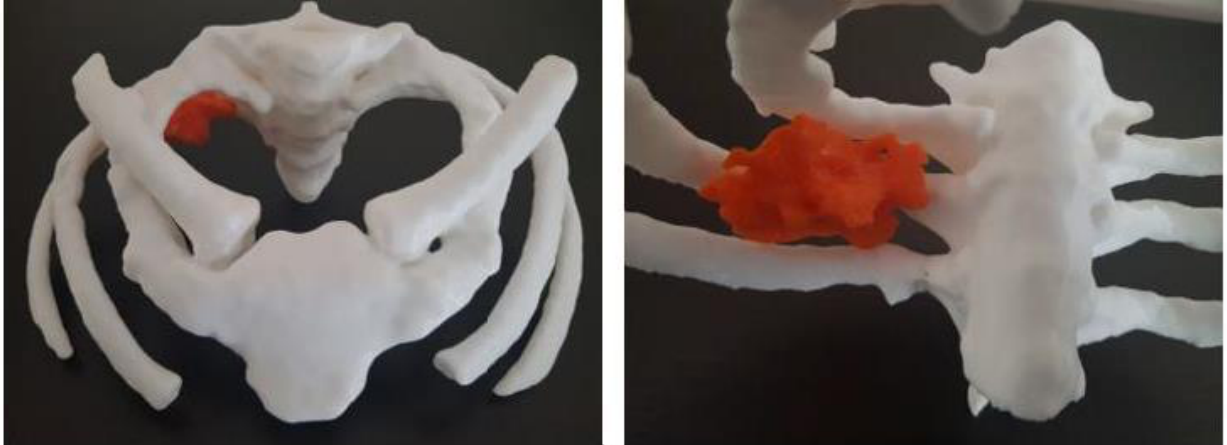
Figure 18. 3D-printed Pancoast lung cancer model and bones. ( Top ) row: frontal and bottom views with magnet (circled). The model was printed with polylactic acid. ( Middle ) row images: ( Top ) view of 3D-printed tumour with magnet and bottom view. ( Bottom ) row images: 3D-printed model with tumour and bony structure added together (frontal and superior views of the exact tumour location in the right lung apex). Reprinted with permission from Yek et al. [72].